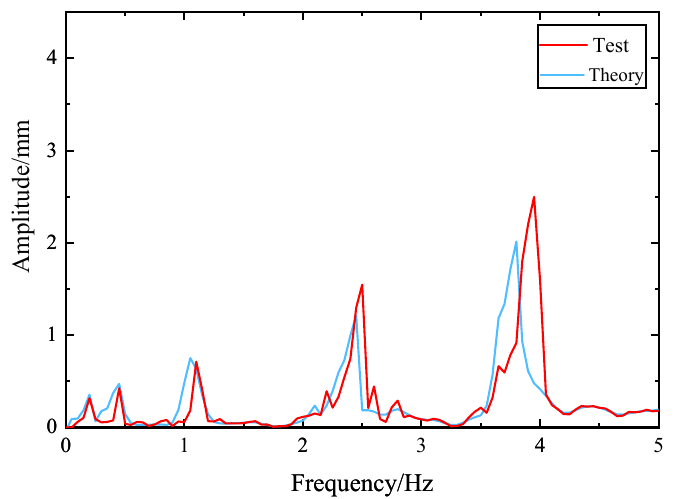
Table 6. Comparison of identification frequency.